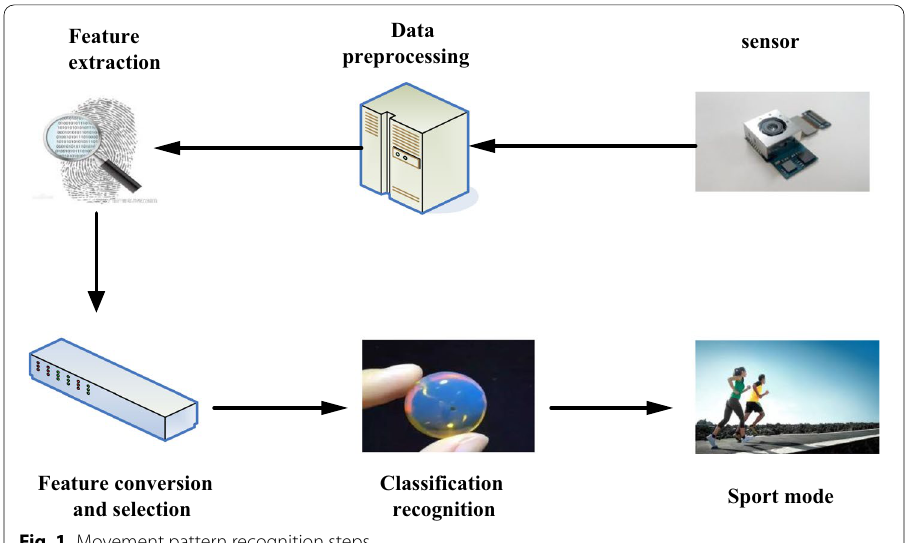
Fig. 1 Movement pattern recognition